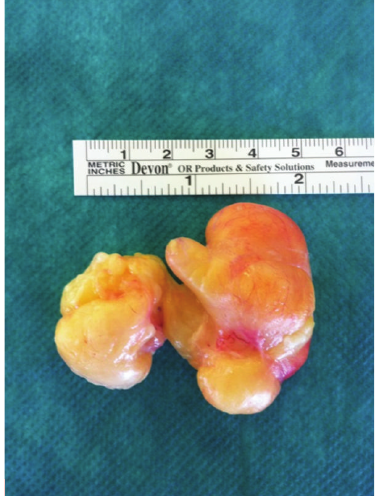
Figure 7: Operating piece after